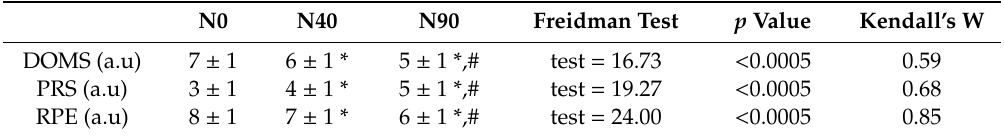
Table 4. Delayed onset muscle soreness (DOMS), perceived recovery status scale (PRS), and rating of perceived exertion scale (RPE) recorded in the 40-min (N40) and the 90-min (N90) of nap opportunities and the no-nap condition